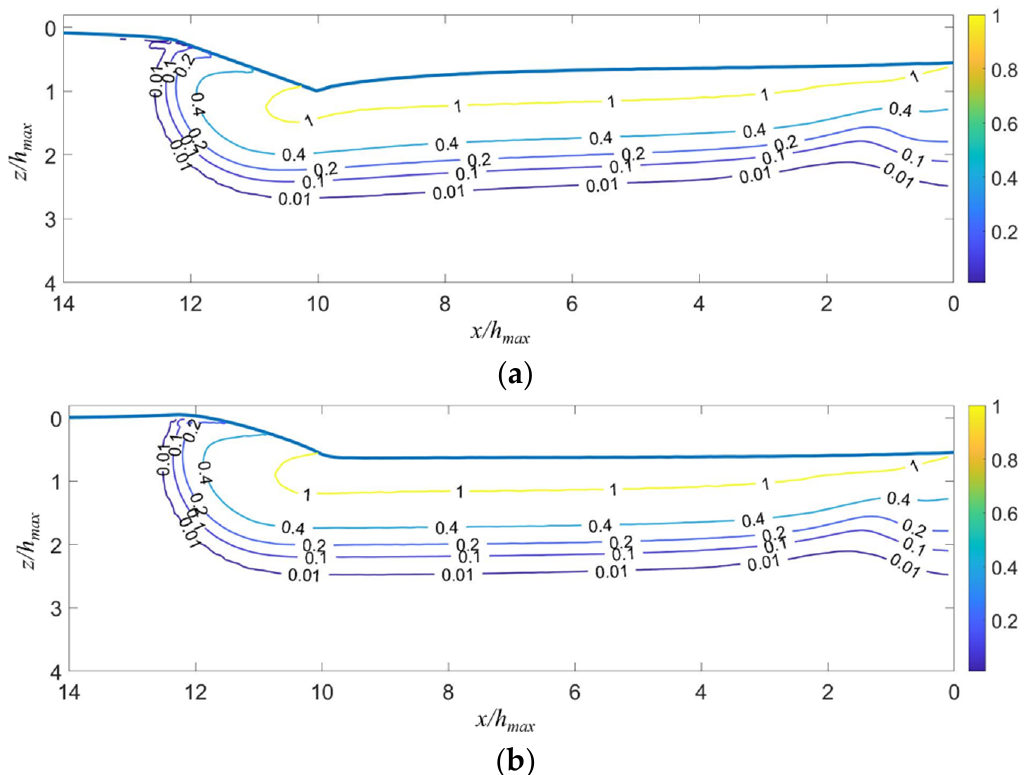
Figure 14. The contours of von Mises equivalent plastic strain in the xz -cross-section ( a ) at the fully loaded and ( b ) fully unloaded states.